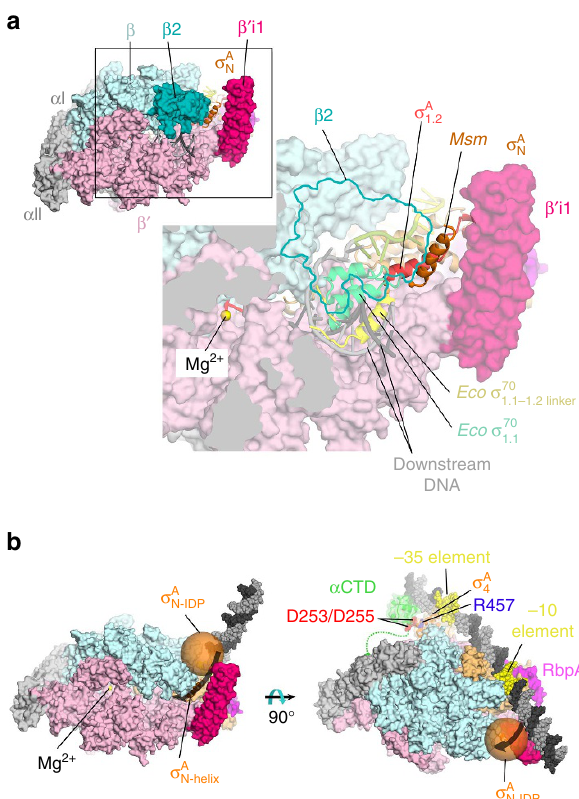
Figure 6 | Structural and functional context of the Msm r A N . ( a ) (upper left) Overall view of the Msm RbpA/RPo. The color-coding is the same as Fig. 1b except the b 2 domain is coloured slate blue. The RNAP is shown as a molecular surface except s A is shown as a backbone ribbon. The nucleic acids are shown in cartoon format. The boxed region is magnified on the lower right. (lower right) Magnified view of the boxed region from the upper right. The b 2 domain (outlined in blue) as well as other obscuring regions of the structure have been removed, revealing the RNAP active site cleft and the nucleic acids therein. The s A , shown as a backbone ribbon, is coloured light orange, except the s A 1.2 N-terminal helix is coloured orange-red, and the s A N - a -helix is coloured orange. Shown in the downstream duplex DNA- binding channel is the superimposed position of Eco s 70 1.1 (light green) and the s 70 1.1–1.2 linker (yellow) from PDB ID 4LK1 (ref. 6). ( b ) Model of an Msm closed promoter complex (RP c or RP1) 4 summarizing the role of the a CTD (green), b 0 i1 (hot pink), and s A N (orange) in RPo formation. The a CTD was modelled bound upstream of the (cid:2) 35 element, placing conserved negatively charged a CTD residues D253/D255 (Fig. 2e; shown as red CPK atoms) near conserved s A 4 R457 (blue CPK atoms), inferring interactions analogous to Eco CTD D259/E261 with s 70 4 R603 (ref. 26). The s A N-helix is shown as an orange backbone ribbon as observed in the crystal structures (Fig. 5a). The rest of the s A N (approximately residues 1–143) is predicted to comprise an intrinsically disordered region (IDR) and is modelled as a (transparent orange) sphere with the expected radius (30Å) of a Flory random coil for an IDR with k (measurement of the extent of charge separation) of 0.42 (ref. 50). The sphere was placed to connect with the N-terminus of the s A N-helix and simultaneously minimize steric clashes. The combined placement of b 0 i1 and the s A N-IDR blocks the path the DNA must traverse to enter the active site cleft (indicated by thick black